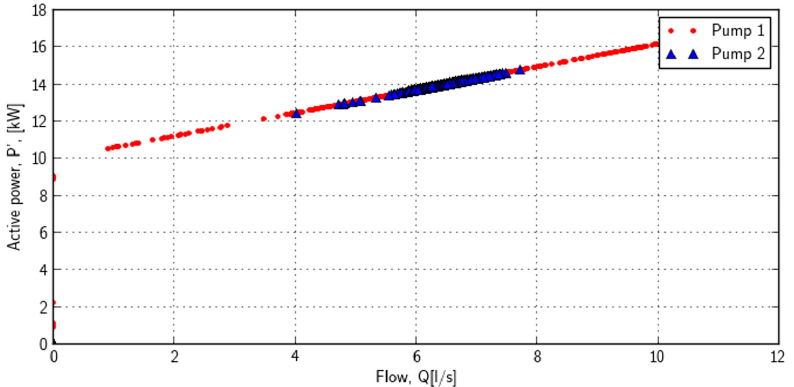
Figure 11. The operating point positions on the PU1 and PU2 P’(Q) characteristics in December 2009.